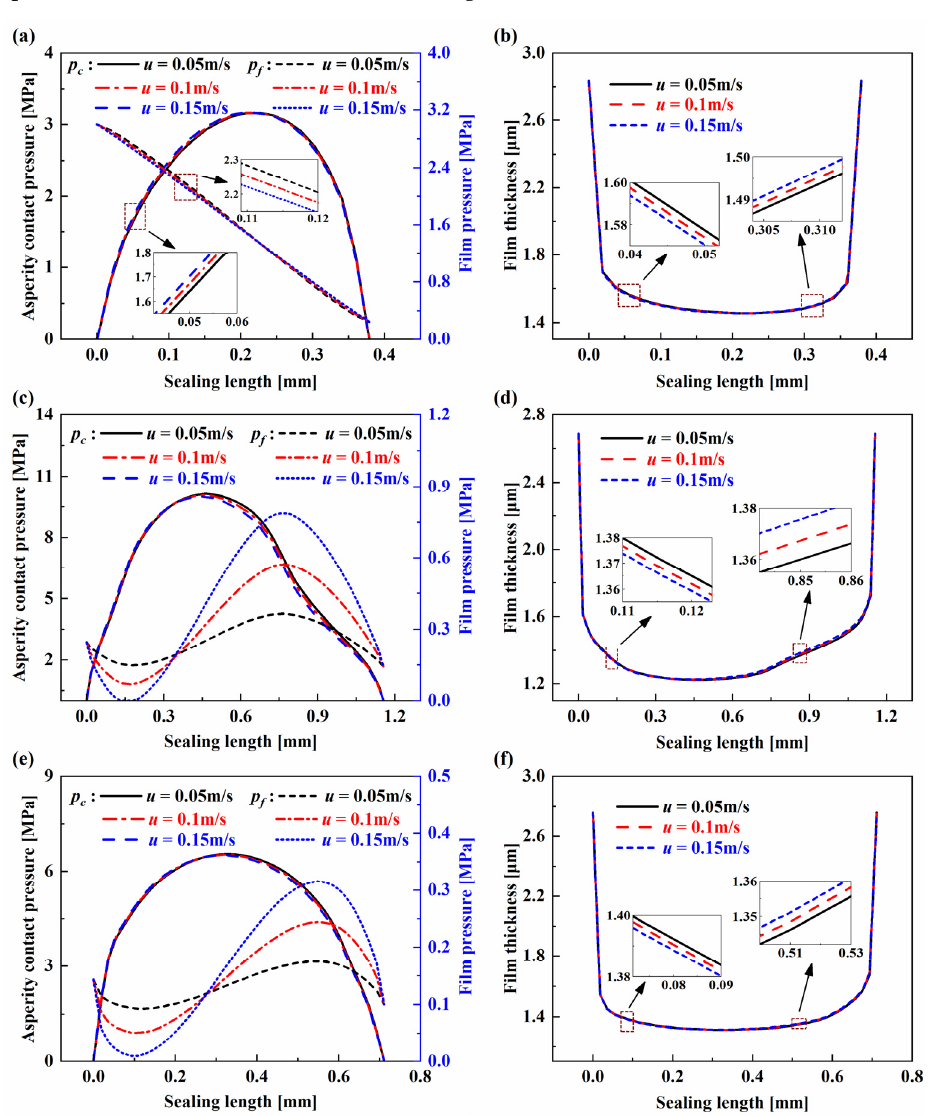
Figure 7. Pressure and film thickness distributions with different piston speed: ( a , c , e ) pressure of the left lip, main lip, and right lip; ( b , d , f ) film thickness of the left lip, main lip, and right lip.